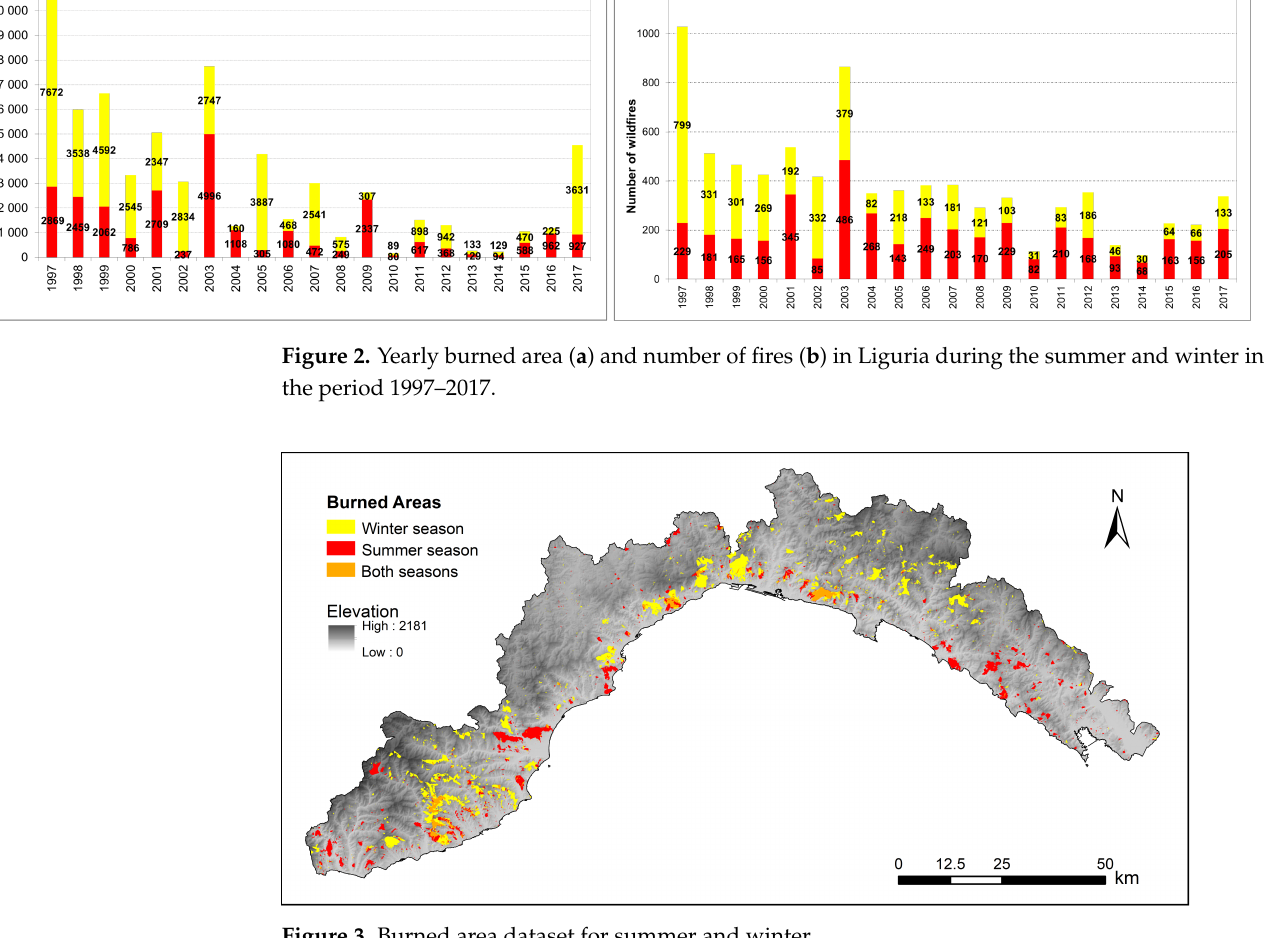
Figure 3. Burned area dataset for summer and